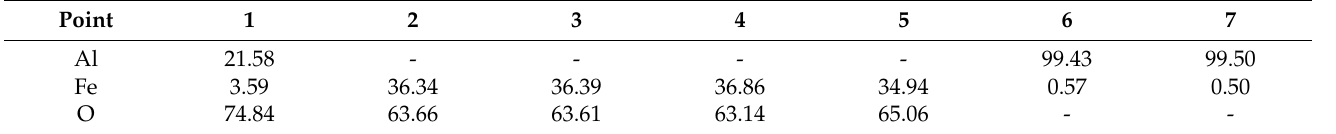
Figure 9. SEM micrograph of the joining zone between steel and aluminum of the gear with 90% de- formation degree. Table 3. The element composition of seven points in the joint zone by EDS spectrum analysis (at